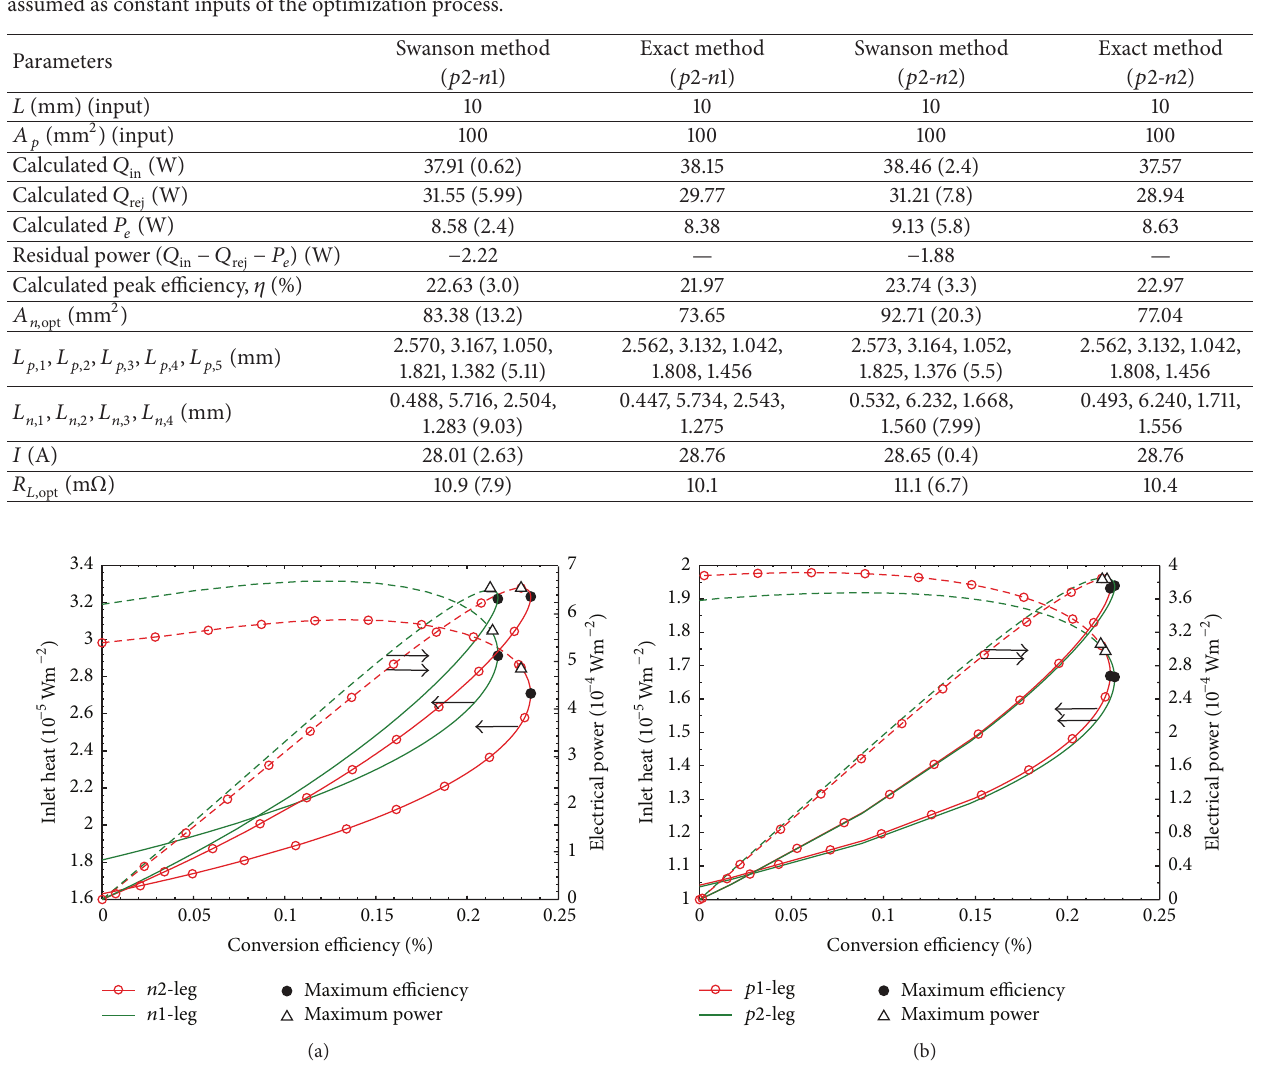
Figure 4: Electrical output power per cross section area and input heat flux versus conversion efficiency for (a) 𝑝 1-leg and 𝑝 2-leg and (b) 𝑛 1-leg and 𝑛 2-leg which have been calculated through exact